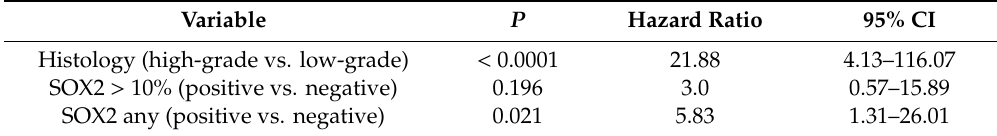
Table 4. Multivariate Cox proportional hazards model to estimate oral cancer risk.